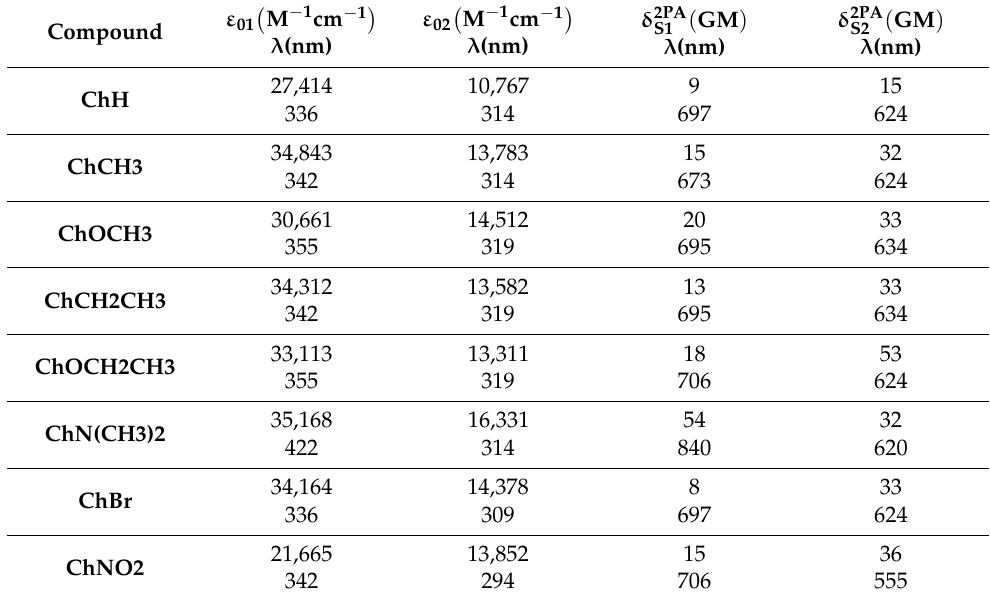
Table 1. Values of ε 01 , ε 02 , 2PA cross-section at the lower ( δ 2 PA all compounds studied in this work. The wavelength of each electronic transition is also shown below. Values of 2PA cross-section are given in Goeppert-Mayer (1 GM = 10 − 50 cm 4 s molecules − 1 photons − 1 ).